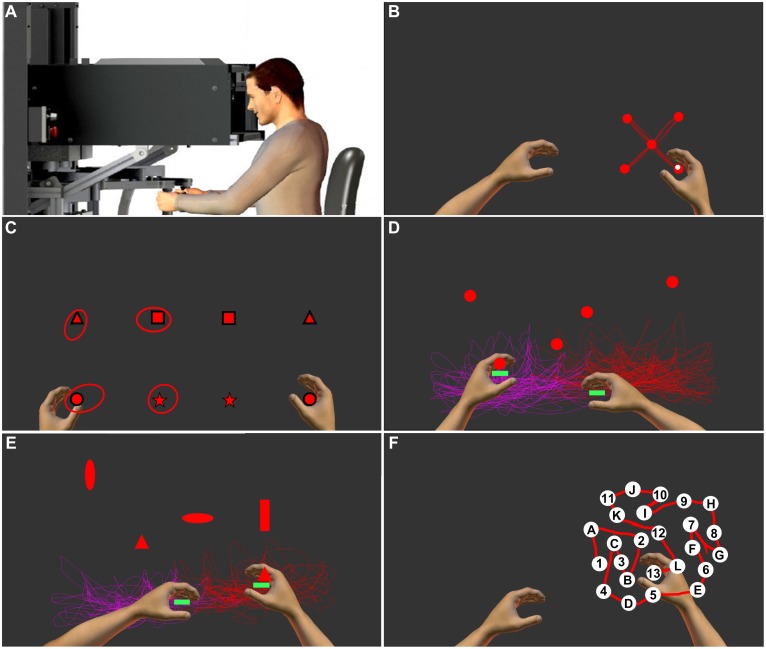
Depiction of the KINARM device and tasks.The KINARM end-point robotic device is shown in panel A and screen shots of a representative participant performing the tasks employed in the other panels (B, 4-target Visually guided reaching; C, 4-target Position Matching; D, Object Hit; E, Object Hit and Avoid; F, Trail Making B). In panel B, the red lines depict representative hand paths when moving to each target location. In panel C, the robot moved the dominant (passive) arm and the participant mirror-matched with the non-dominant (active) arm. Shapes represent each target location and the corresponding mirror matched position. Ellipses around the targets represent variability in position matching across trials. In panels D and E, red and purple lines depict dominant and non-dominant hand movements throughout the task. Green rectangles represent paddles that participants use to hit objects. In panel F, the red line depicts the participant’s hand path.